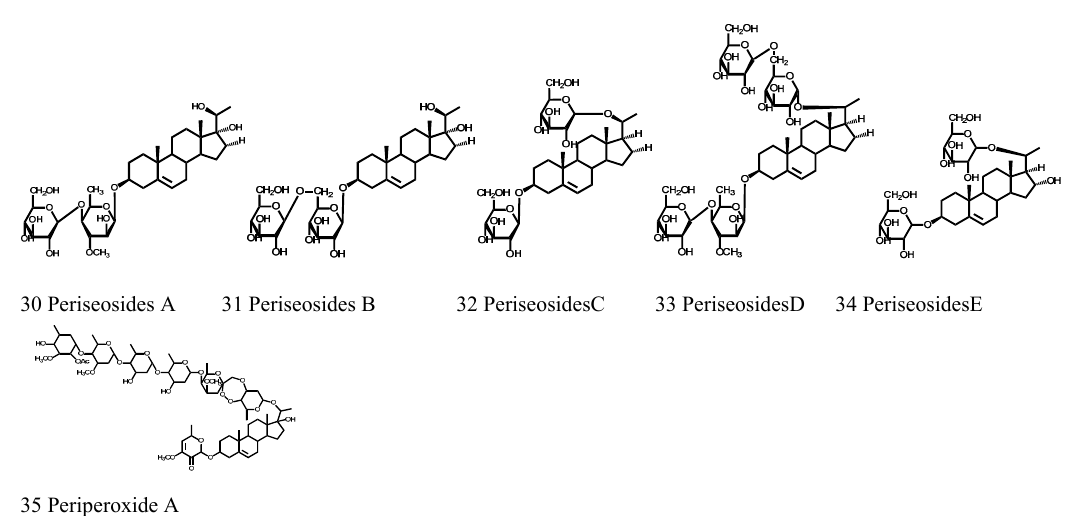
Figure 1. The structures of C 21 -steroidal glycosides (1–35) obtained from Cortex Periplocae .